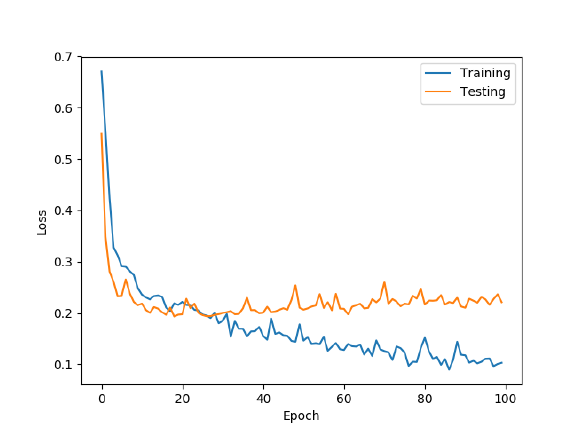
Figure 3. Loss function